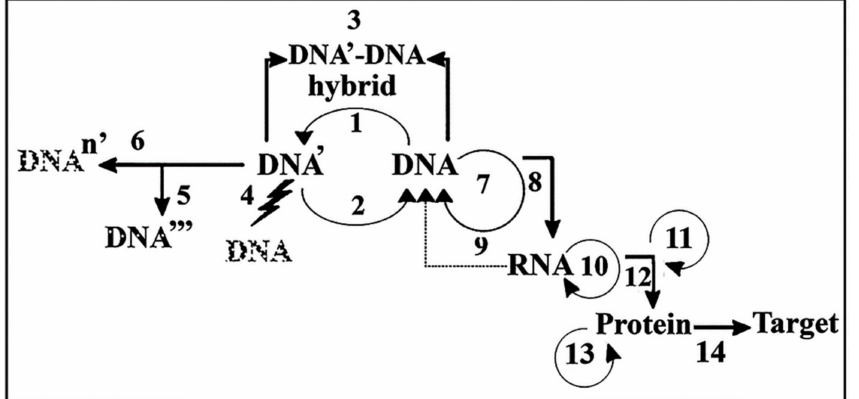
Figure 5. The hierarchical arrangement of transfer processes involved in genetic information. Pro- cesses of the DNA Empire take place at DNA, RNA and protein levels: DNA ↔ DNA transfer processes : 1. Mutation: DNA => DNA’; 2. DNA repair: DNA’ => DNA; 3. Recombination: crossover, gene conversion (DNA’–DNA hybridization). Recombination can take place intracellularly but is mainly an intercellular process; 4. Apoptosis (programmed cell death, high levels of DNA damage); 5. Aging, several mutations, persistent DNA damage: DNA’ => DNA” => DNA”’; 6. Malignant transformation with multiple mutations: DNA => DNA n ’ (persistent DNA damage, many mutations, mutant p53); 7. DNA replication: DNA <=> high fidelity (HiFi) process, (1:10 10 misincorporated deoxyribonucleotide). DNA ↔ RNA processes : 8. Medium-fidelity (MeFi) process, 1:10 5 misincorpo- rated ribonucleotide); 9. Reverse transcription: RNA => DNA (in retroviruses); 10. RNA replication: RNA <=> RNA. Processes belonging to posttranscriptional modifications : 11. 5’-cap formation, 3’-polyA formation, splicing; 12. Translation: RNA => protein (low fidelity, LoFi process, 1:10 4 misincorporated amino acid). Processes belonging to protein modification : 13. protein splicing, transglutamination; 14. Protein targeting: information reaches its intra- or extra-cellular destination. Figure 5 was used with the permission of [22]. Dotted letters of DNA represent mutations. Arrow resembling lightning refer to many mutations occurring within a short period of